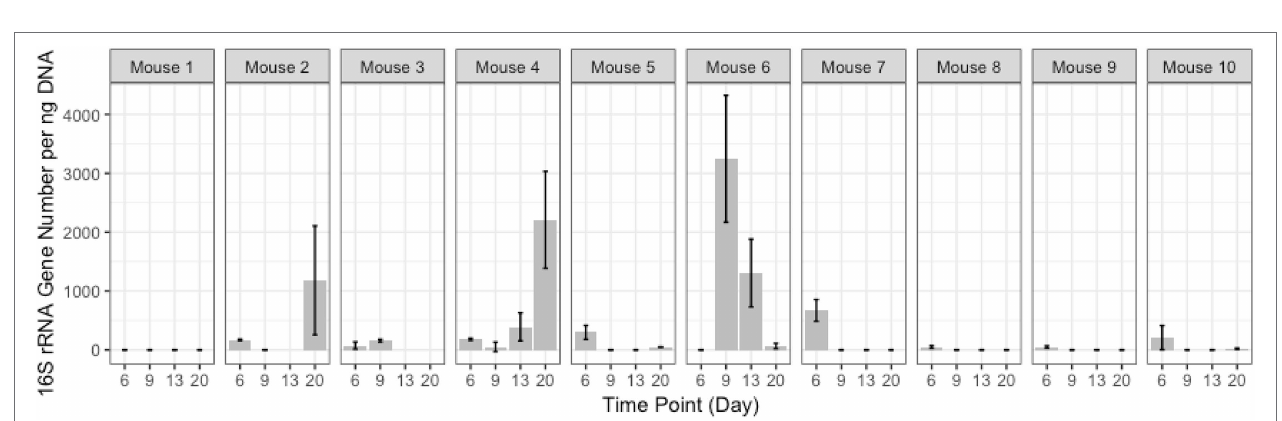
FIGURE 6 | Resistant Clostridiales OTUs. The fold change of relative abundance of Clostridiales OTUs 1 and 3, ( A,B , TZP1 and TZP2, respectively) compared to the last pre-antibiotic time point (Days 6 and 14, respectively) are plotted for each day. The vertical line indicates the approximate first TZP exposure. Mice 1–10 were immunocompetent while mice 11–20 were